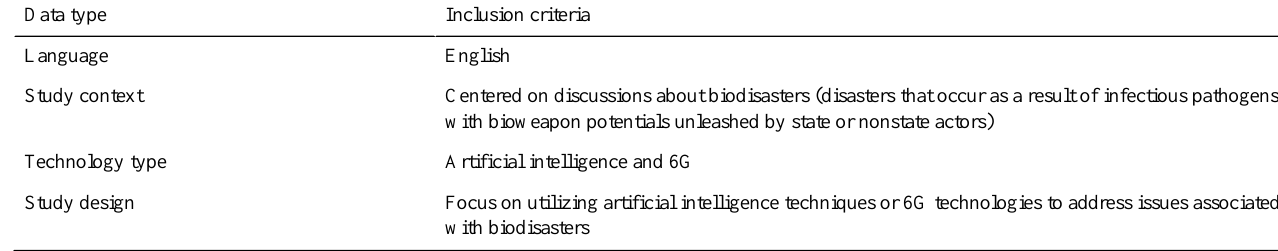
Table 2. Study inclusion criteria. EnglishLanguage actors)Study context